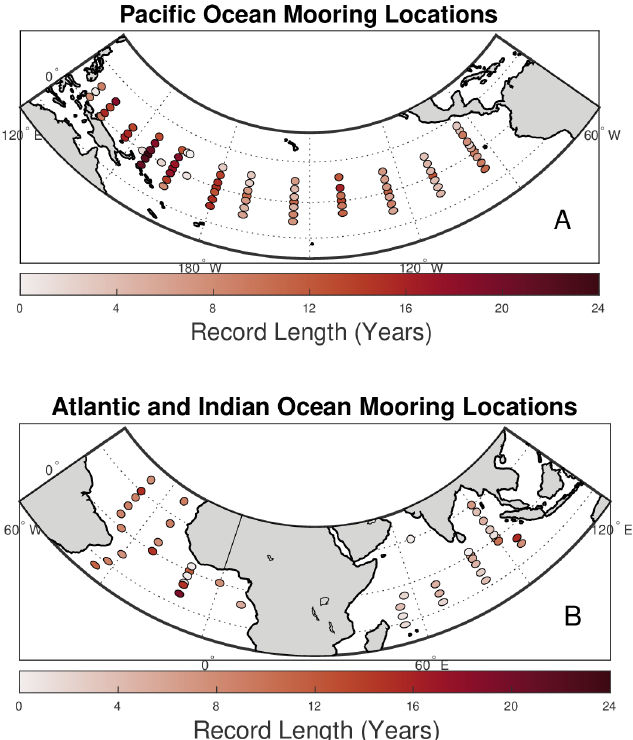
Figure 1. The Global Tropical Moored Buoy Array. (a) The array is called “TAO” in the eastern and central Pacific, “TRITON” in the western Pacific, (b) “PIRATA” in the Atlantic and “RAMA” in the Indian ocean. Note, some sites are not currently operational, especially in the western Pacific. Symbol colors correspond to the length of the record in years, with a scale at the bottom. The record length refers to the total number of hourly measurements regardless of gaps.